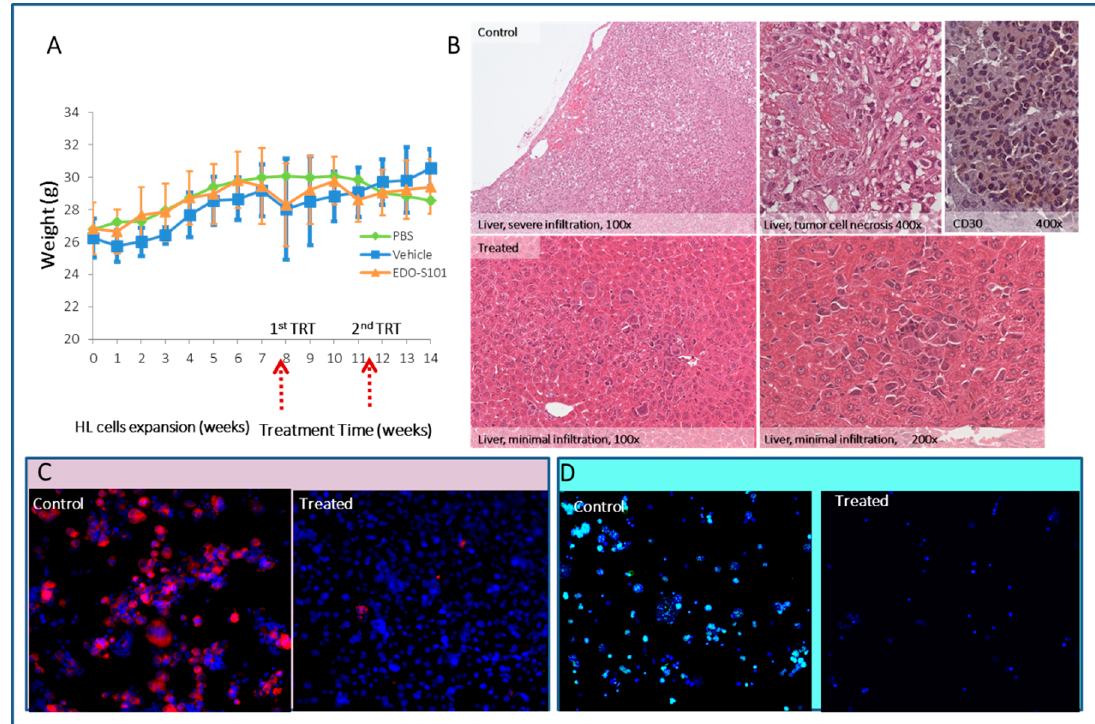
Figure 18. In vivo administration of two successive EDO-S101 doses (60 mg/mL). ( A ) Decrease of weight of mice after each injection of EDO-S101 and of vehicle, after which, weight was regained. ( B ) Tumor cell infiltration in the livers of control and of treated mice demonstrated by immunohistochemistry after ( B ) H&E, ( C ) CD30, and ( D ) human centromere staining (green signal) after three weeks of treatment. Thirty mice were treated with two successive EDO doses seven weeks after HL cell transplantation. Mice were sacrificed seven weeks after EDO treatment (10× magnification).